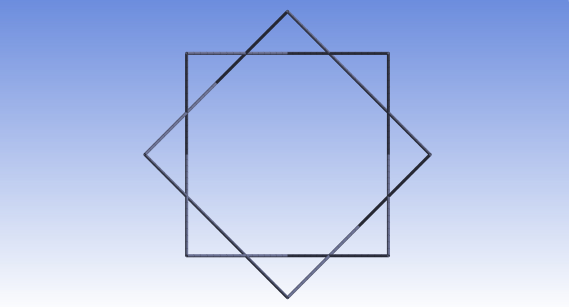
Figure 1. End view of IsoTruss structure [26].